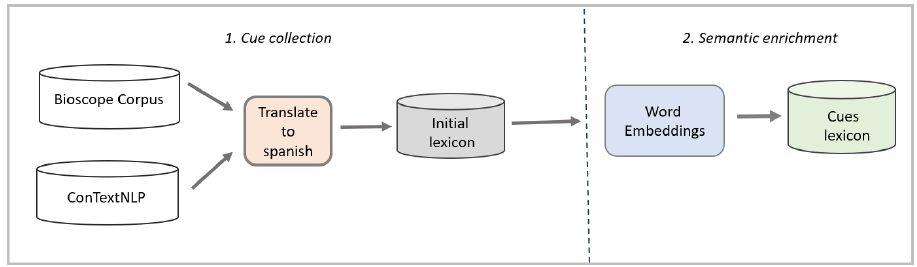
Figure 4. Strategy to generate the cues